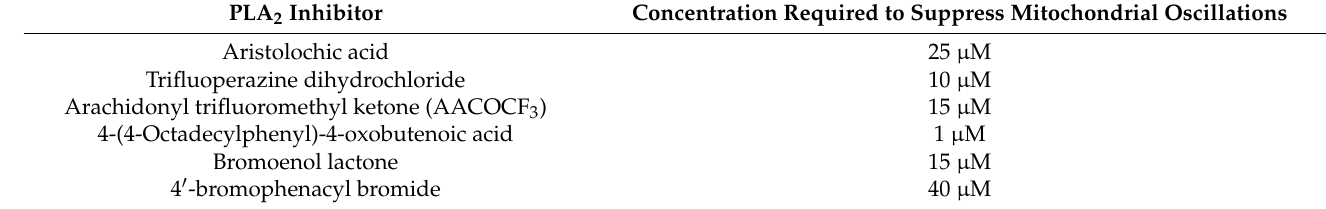
Table 1. Phospholipase A 2 inhibitors capable of preventing the Sr 2+ /valinomycin-induced oscillatory state of rat liver mitochondria.